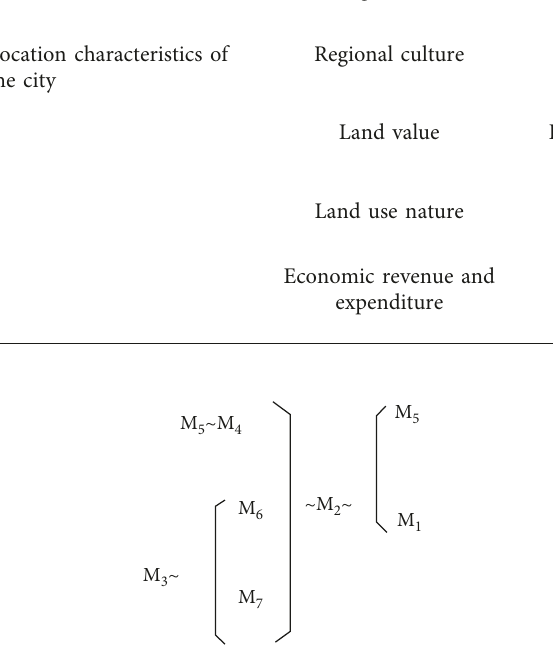
Figure 4: Network of relationships.